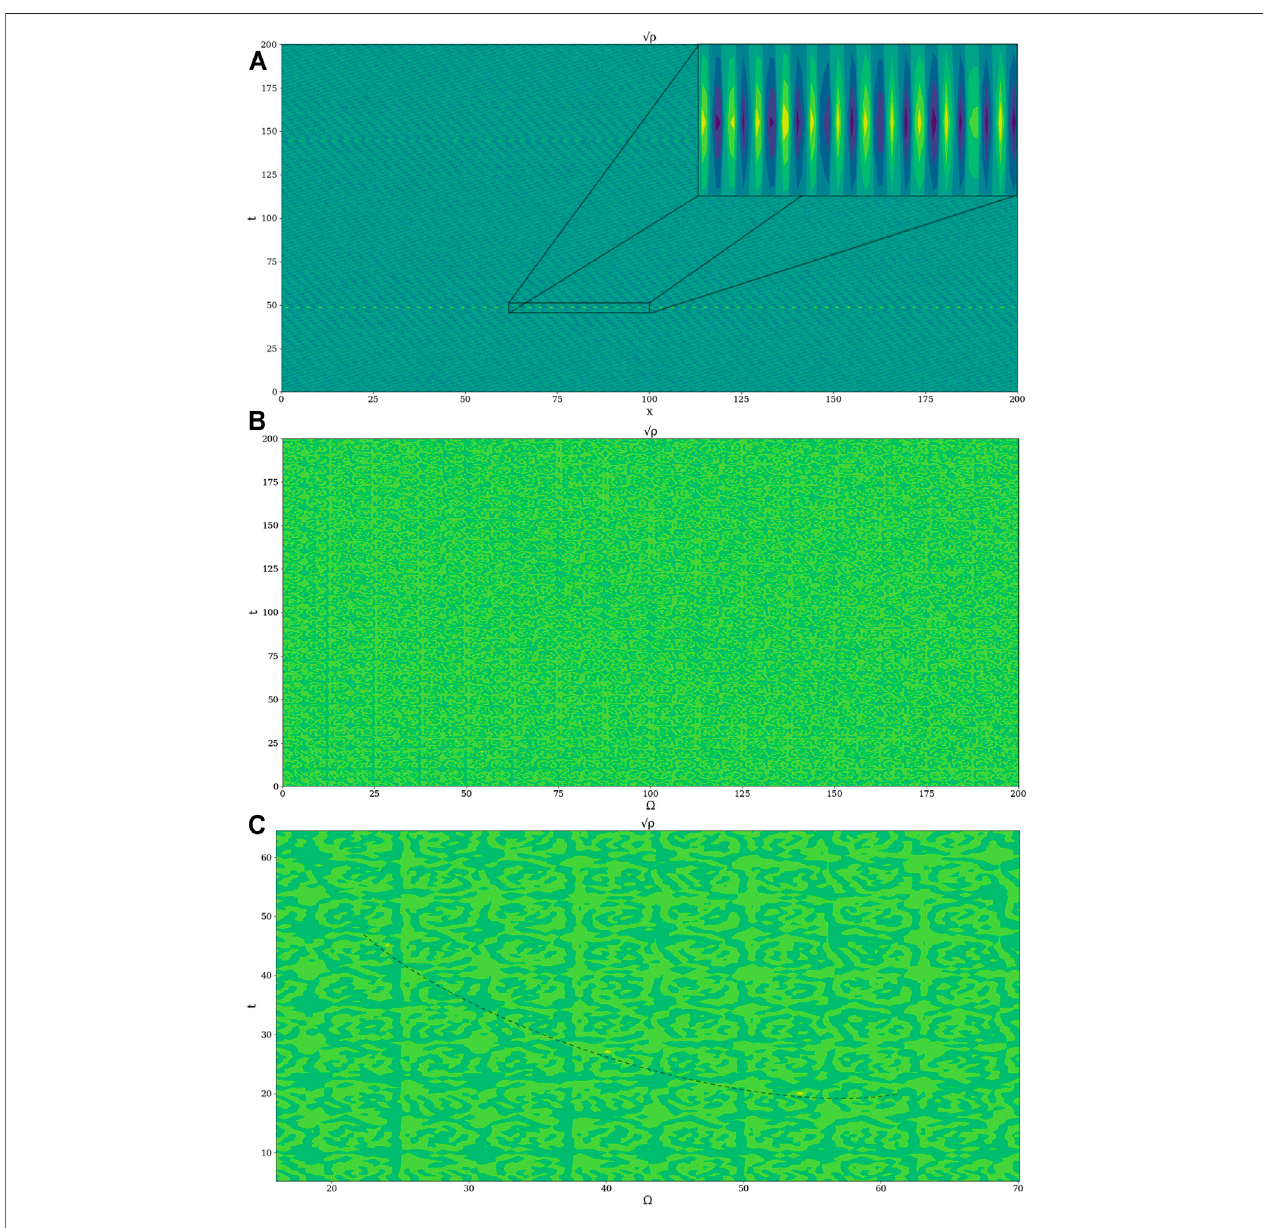
(cid:6) √ ρ ( x , t ) ; (A) zoom-inofmultifractalsynchronizationmodes(top-right); Ω (cid:2) 2 . 1, Φ (cid:2) 2 . 35, (B) x (cid:2) 5, Φ (cid:2) 2 . 35, (C) zoomed-inregion FIGURE6| Example2Dplotof (cid:6) √ ρ ( Ω , t ) multifractal synchronization modes; dotted line roughly shows synchronization modes distribution; x (cid:2) 5. Φ (cid:2) 2 . 35 . of